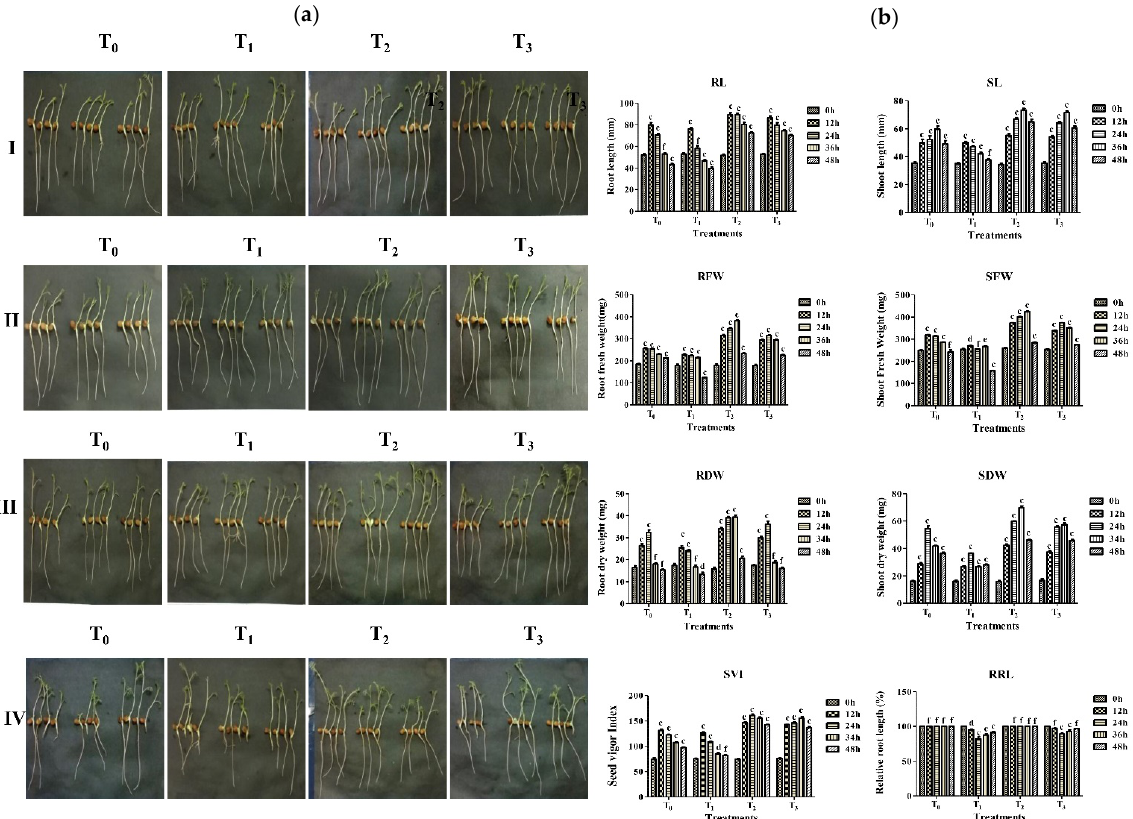
Figure 5. ( a ) Influence of the bacterial strain A7 against aluminum toxicity on the growth promotion of chickpea at 12 h interval of time for 48 h at 14 h photoperiod in white light with a photon flux intensity of 220 mol m − 2 s 1 (PAR) in three biological replicates. (I) at 12 h, (II) at 24 h, (III) at 36 h, and (IV) at 48 h. T 0 = Control (with no bacteria and aluminum), T 1 = AlCl 3 (only 100 µ M of aluminum chloride), T 2 = A7 (only freshly grown 0.1 OD 600 cells of A7) and (4) T 3 = A7 + AlCl 3 (freshly grown 0.1 OD 600 cells of A7 + 100 µM of aluminum chloride). ( b ) Bar diagram showing different growth parameters of the chickpea plants with the influence of the bacterial strain A7 against aluminum toxicity after 12, 24, 36, and 48 h of incubation. RL = Root Length, SL = Shoot Length, RFW = Root Fresh Weight, SFW = Shoot Fresh Weight, RDW = Root Dry Weight, SDW = Shoot Dry Weight, SVI = Seed Vigor Index and RRL = Root Relative Length. Values are expressed as means (n = 3) ± Stand- ard Error Mean (SEM). Each replicate consists of sixteen plants per jar. Statistical differences were analyzed by two-way analysis of variances (ANOVA). Significant differences (c = p < 0.001, d = p < 0.01, e = p < 0.05 and f = p > 0.05, followed by Bonferroni Posttests) compared with the control. Table 6. Influence of strain A7 on the growth of chickpea in a stressed condition. Time